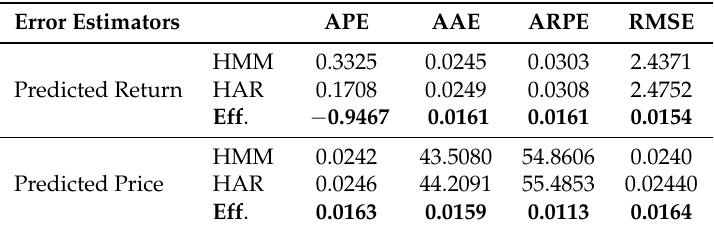
Table 4. Error and efficiency of S&P 500’s predicted prices and predicted returns using the HMM versus HAR model.